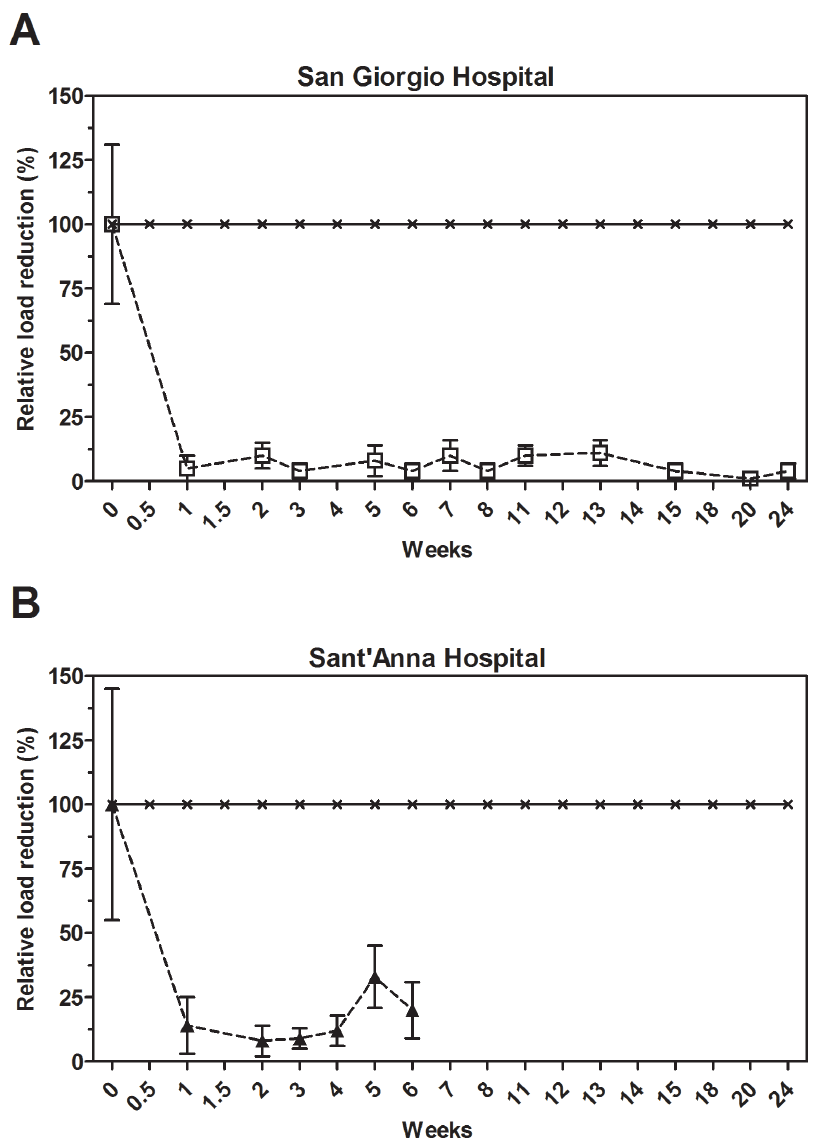
Figure 4. Effect of microbial cleaning on Candidaalbicans surface counts. Surface counts are reported as relative percentage of reduction compared to the control, which was cleaned with conventional (disinfecting) cleaning products. The analysis indicated that results observed were statistically significant (Table S5).